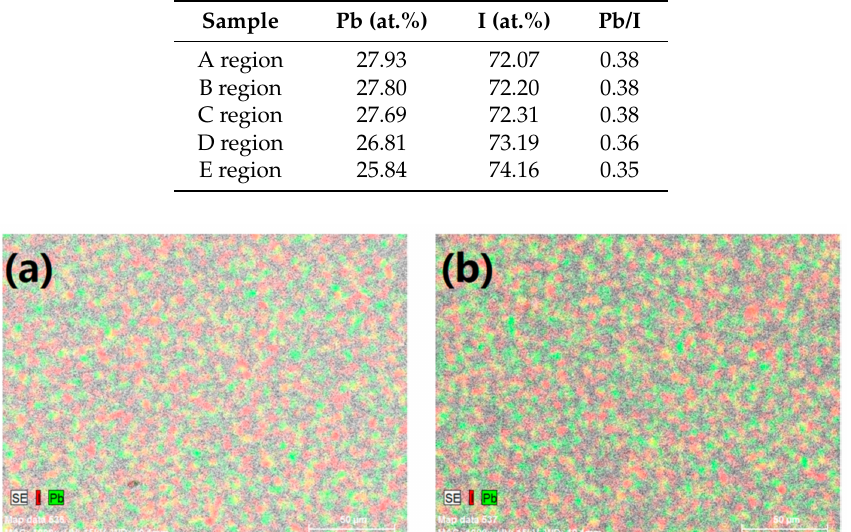
Table 1. The composition of as-deposited films and solvent annealed films determined by EDS